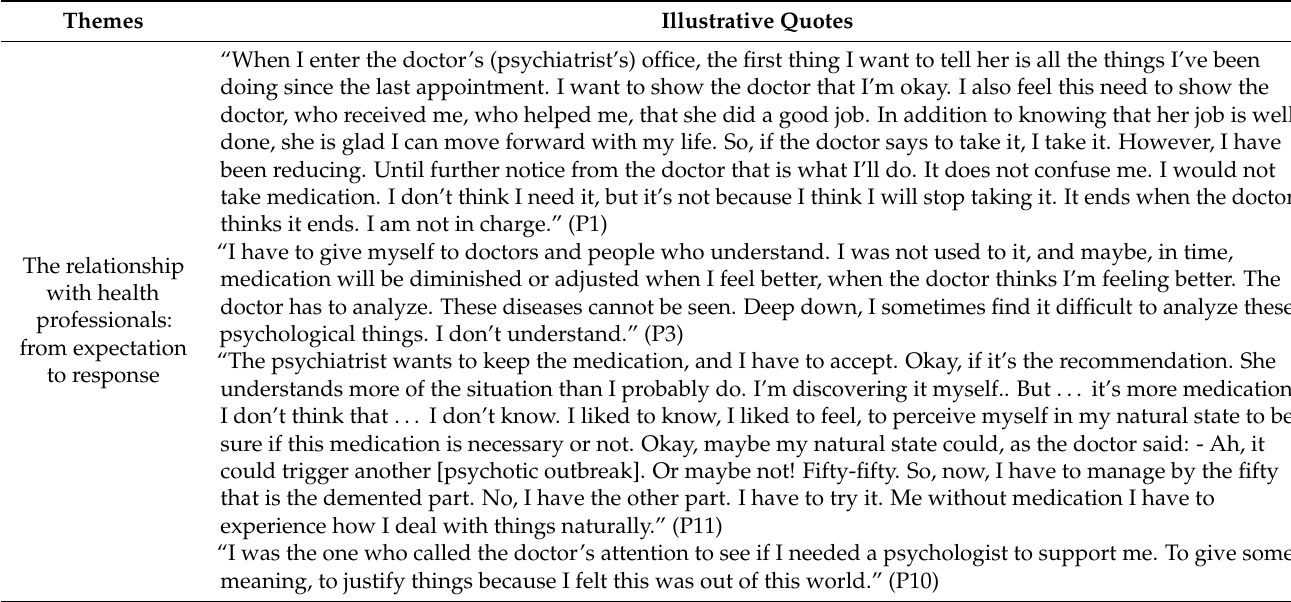
Table 2. Illustrative quotes for themes regarding the constitutive pole of relationships.